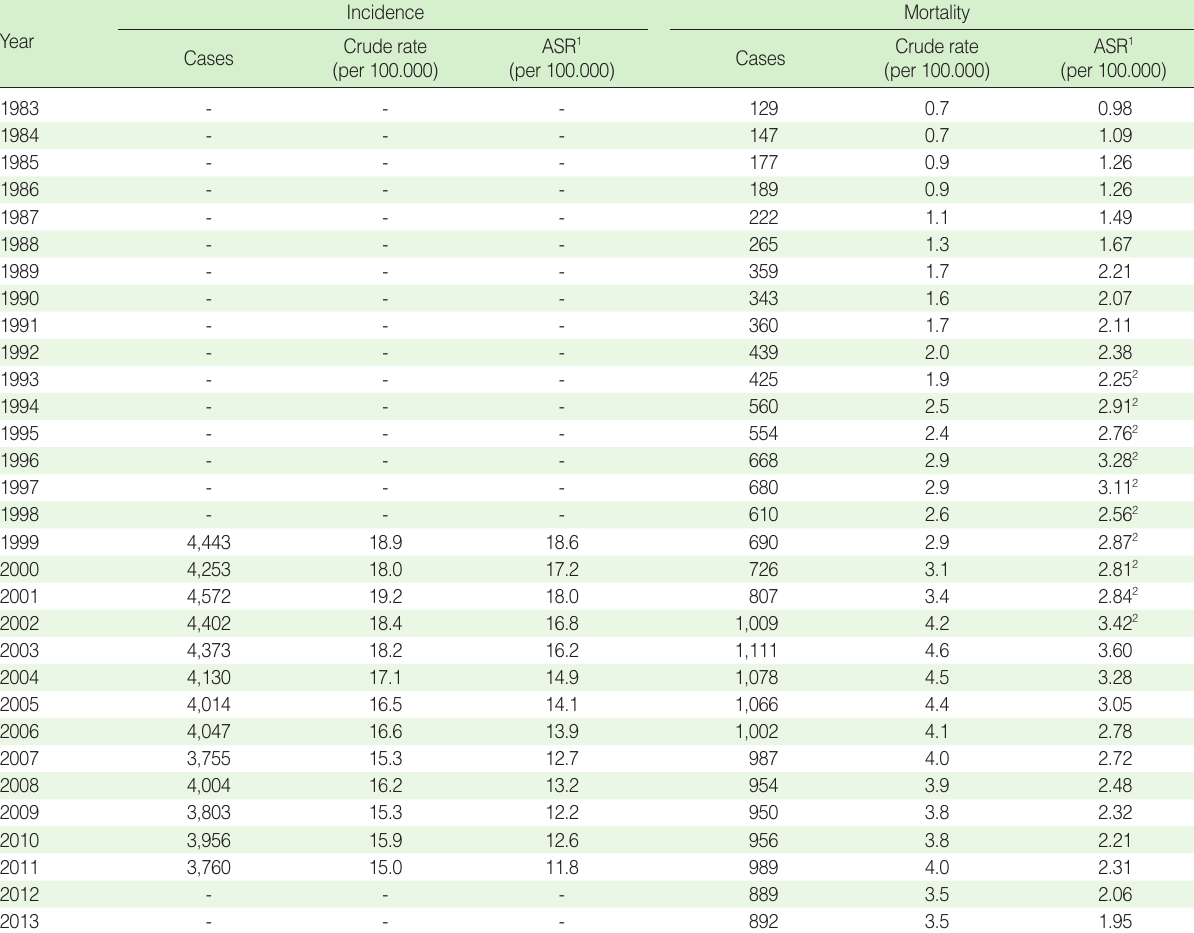
Table 1. Incidence rate (1999-2011) and mortality rate (1983-2013) by year of cervical cancer in Korea